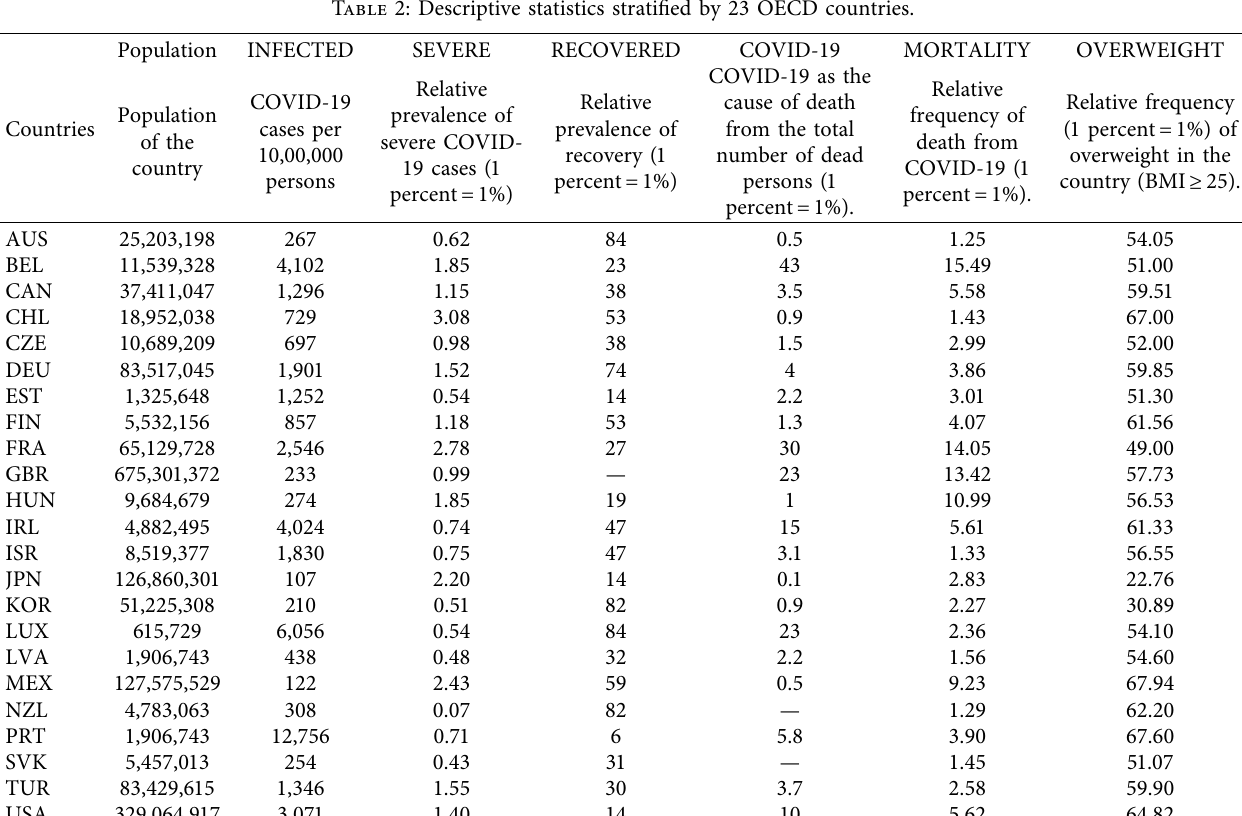
Table 2: Descriptive statistics stratified by 23 OECD